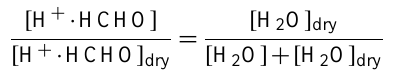
Fig. 5. Sensitivity of HCHO PTR-MS signal m/z 31 as a function of sample flow water amount. Data points for m/z 59, 79 and 93 correspond to signals of acetone, benzene and toluene, respectively. Solid ines are the calculated dependence according to Eq. (3), us- ing the labeled rate constants for the reverse reaction, R1a. Dashed line is the calculated dependence according to Eq. (5), represent- ing equilibrium approach. Mixing ratios of formaldehyde, acetone, benzene, toluene are about 17, 10, 10, 10ppbV, respectively.